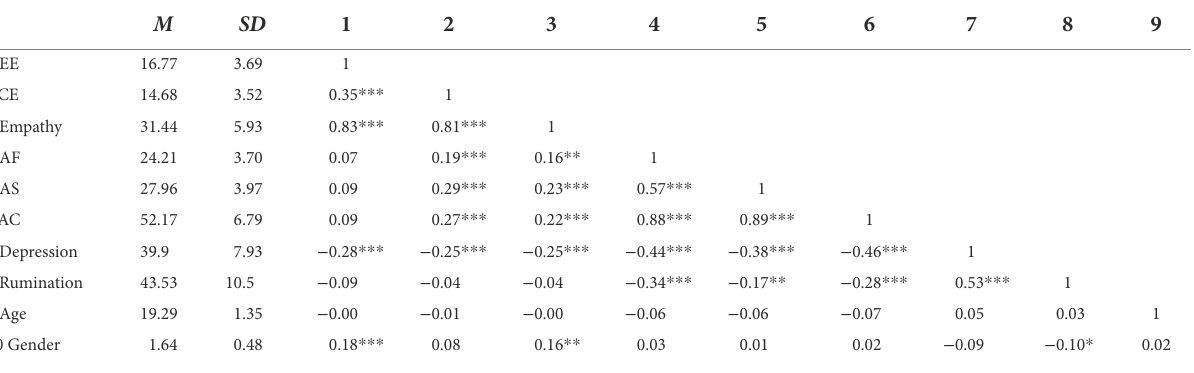
TABLE 1 The results of descriptive statistics and correlation